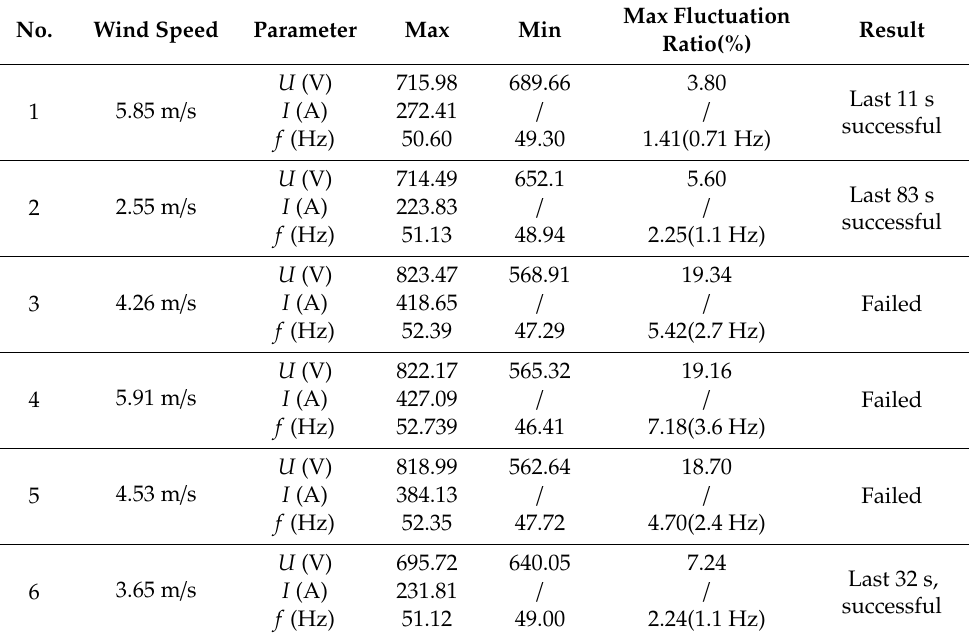
Table 3. The list of parameters of wind turbine generator for self-starting